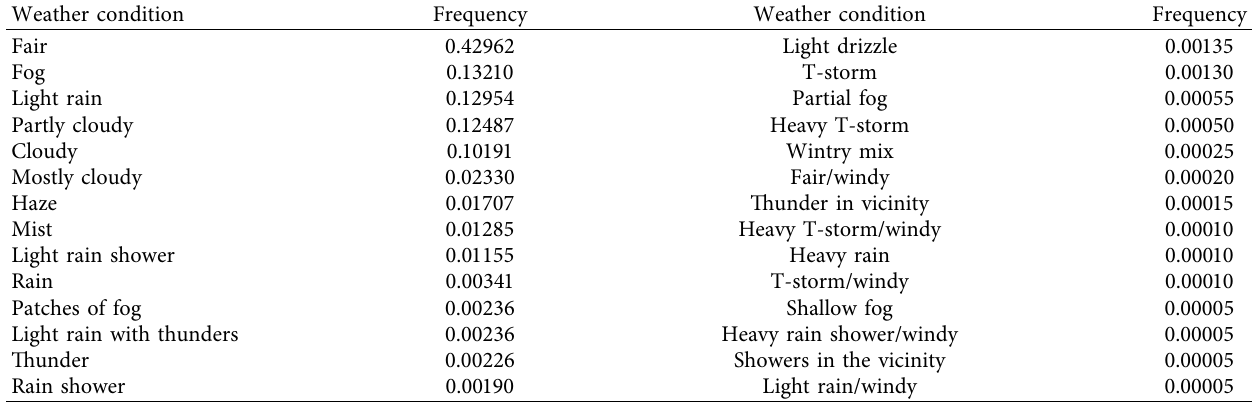
Table 2: Chongqing’s weather conditions normalized frequency distributions.